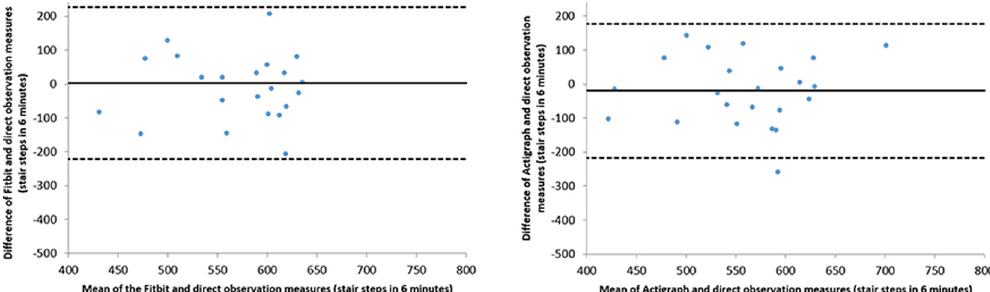
Fig 2. Bland-Altman plots of stair steps for the Fitbit and Actigraph compared to direct observation.